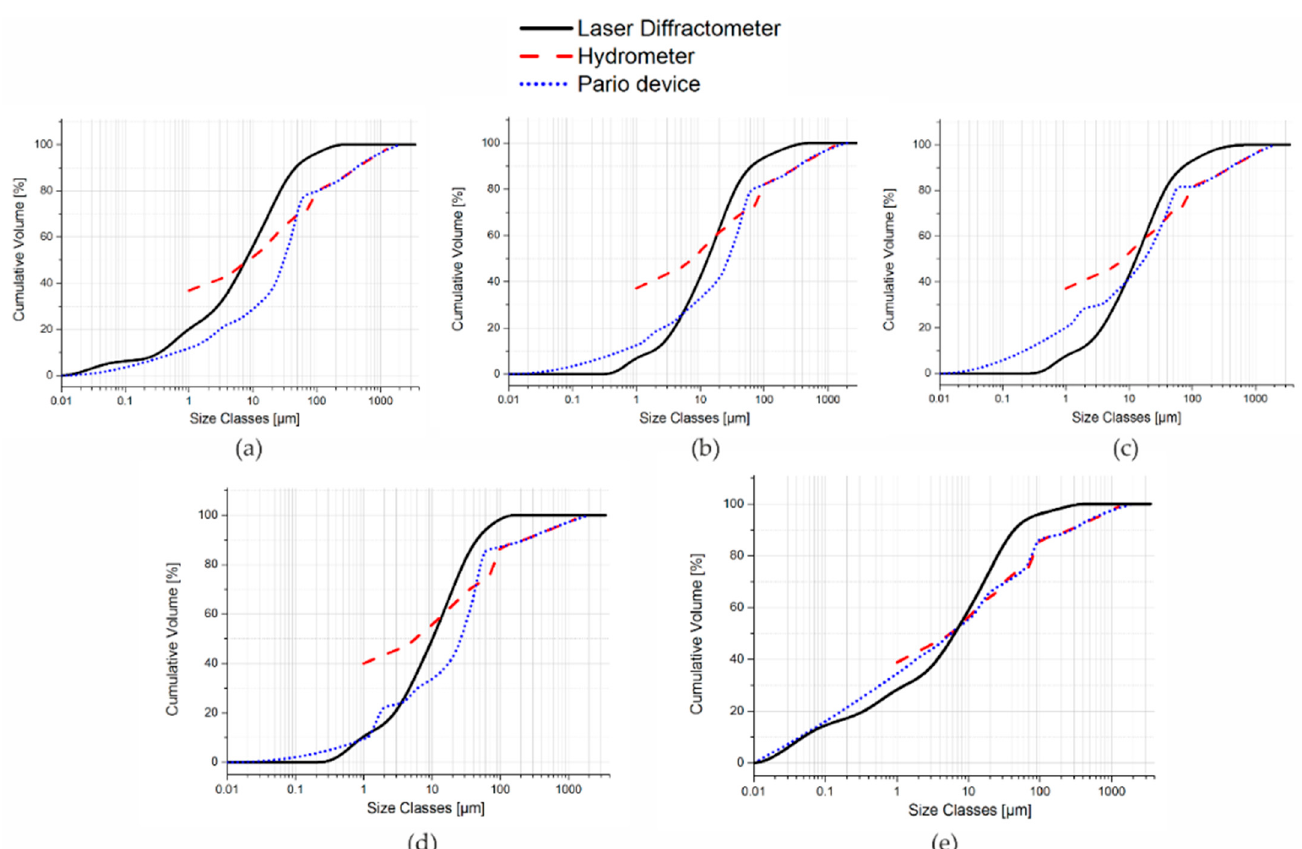
Figure 3. Comparison of PSD curves of soil samples measured by three tested methods–LD (black, solid), hydrometer (red, dashed) and PARIO (blue, dotted): ( a ) Sample 1; ( b ) Sample 2; ( c ) Sample; ( d ) Sample 4; ( e ) Sample 5. Table 1. Comparison of average differences of representation of particles smaller than 2, 10 and 50 μ m between three tested methods ( ± SD), differences between the results for methods in the first and the last column.